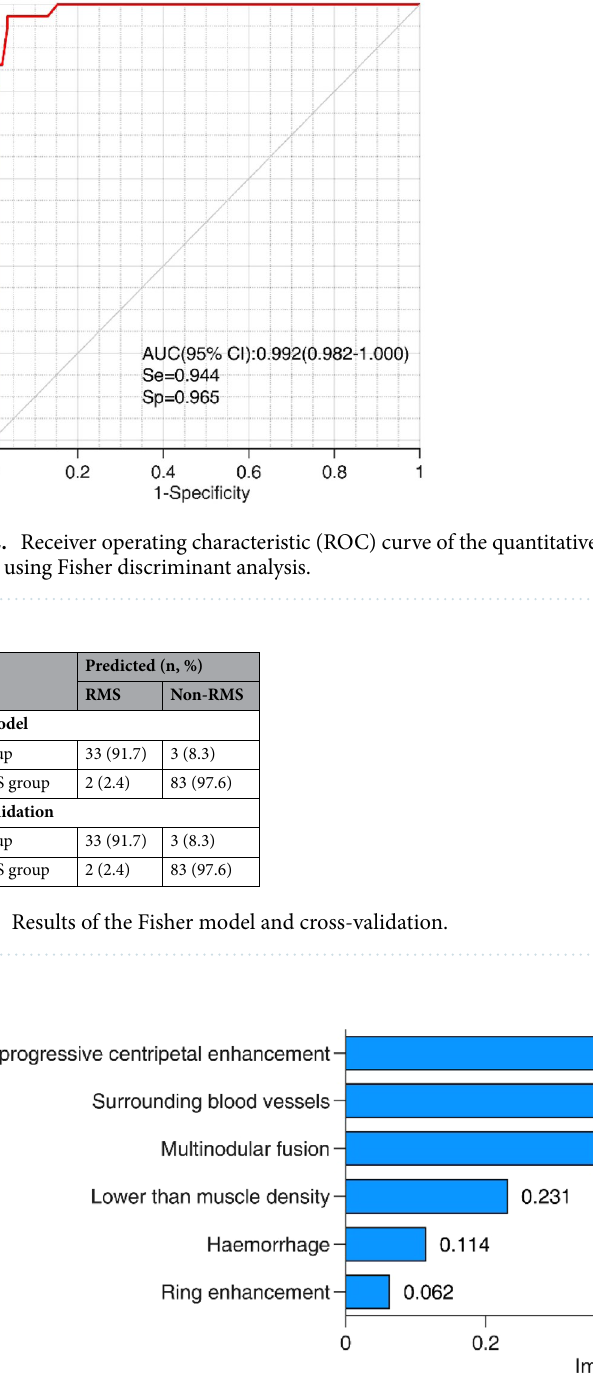
Figure 3. Importance of fisher discriminant model